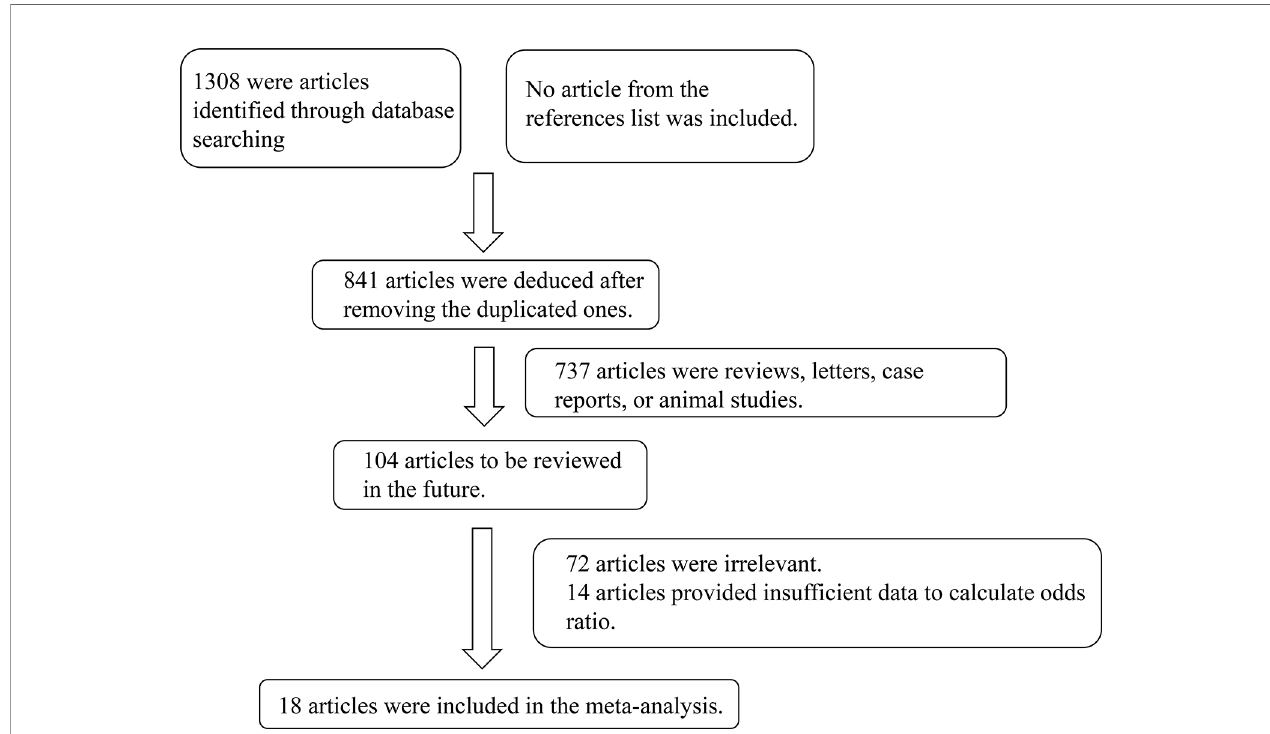
FIGURE 1 | Flow chart showing the detailed procedure for the inclusion or exclusion of